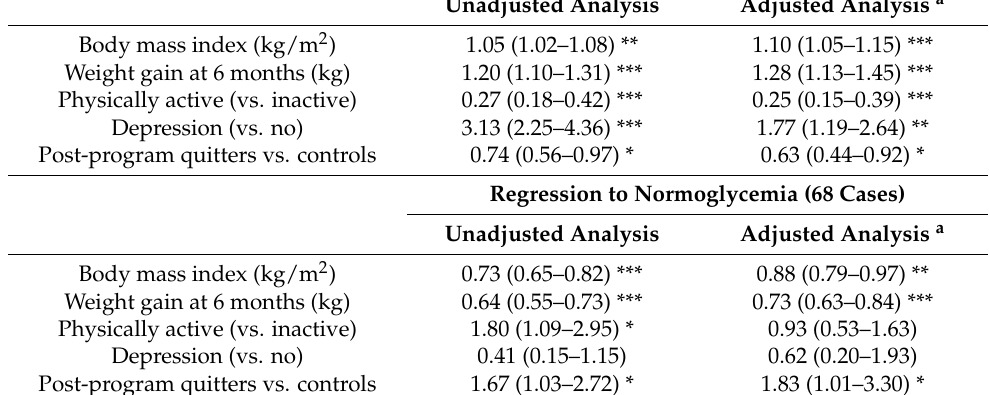
Table 2. Factors for long-term glycemic outcomes among prediabetic smokers in the time-varying analysis ( n = 532).